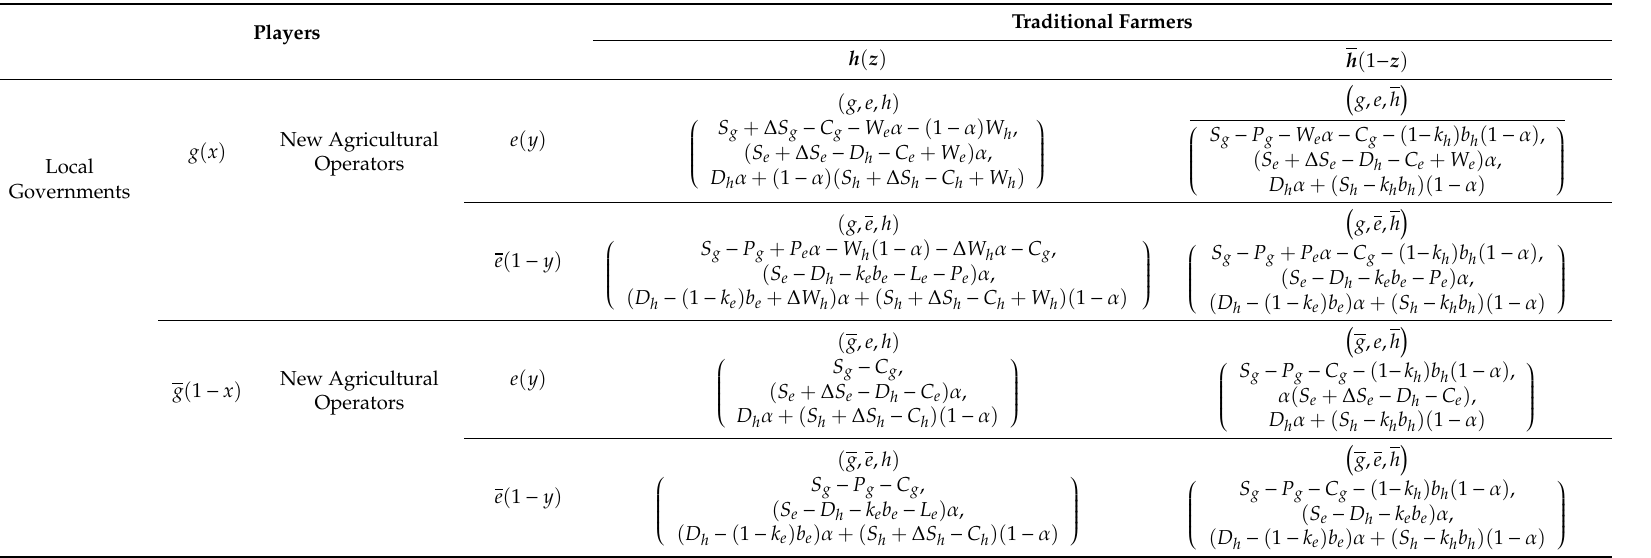
Table 1. The payo ff matrix of the trilateral evolutionary game